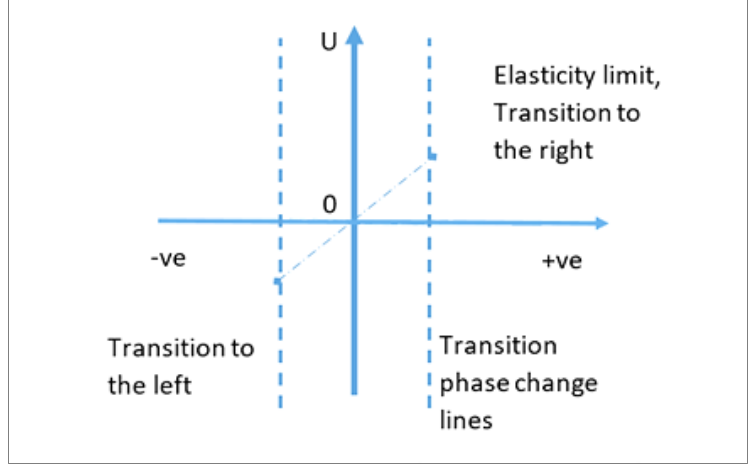
Figure 9. Elasticity of utility based on phase transition boundaries